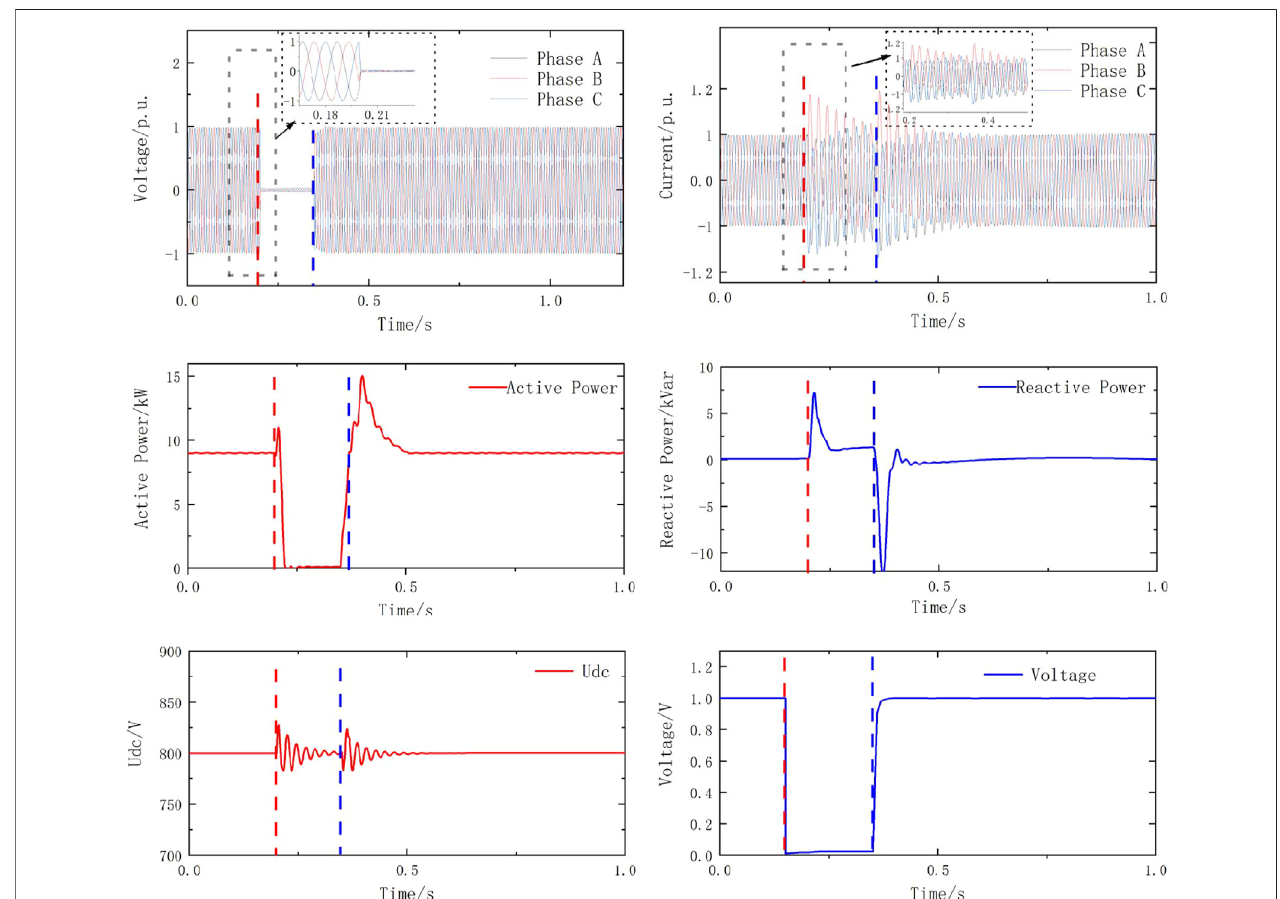
FIGURE 6 | Low-voltage crossing simulation when the voltage drops to